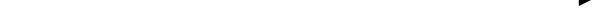
Fig. 7. Schematic summary of the location of auroral forms in MLAT/MLT coordinates, representing the times t 0 (1058 UT), t 1 (1104 UT), t 2 (1108 UT) and t 3 (1115 UT).The circle marks the approximate field of view of the red line filtered all-sky camera in Ny A˚ lesund. Arrowed meridian lines indicate the field-of-view of meridian scanning photometers (MSPs) in Danmarkshavn (near 1300 MLT) and Ny A ˚ lesund (near 1430 MLT), representing (cid:24) 1100 UT. The estimated location of the ionospheric projection of the magnetopause reconnection line is shown by dashed curved line